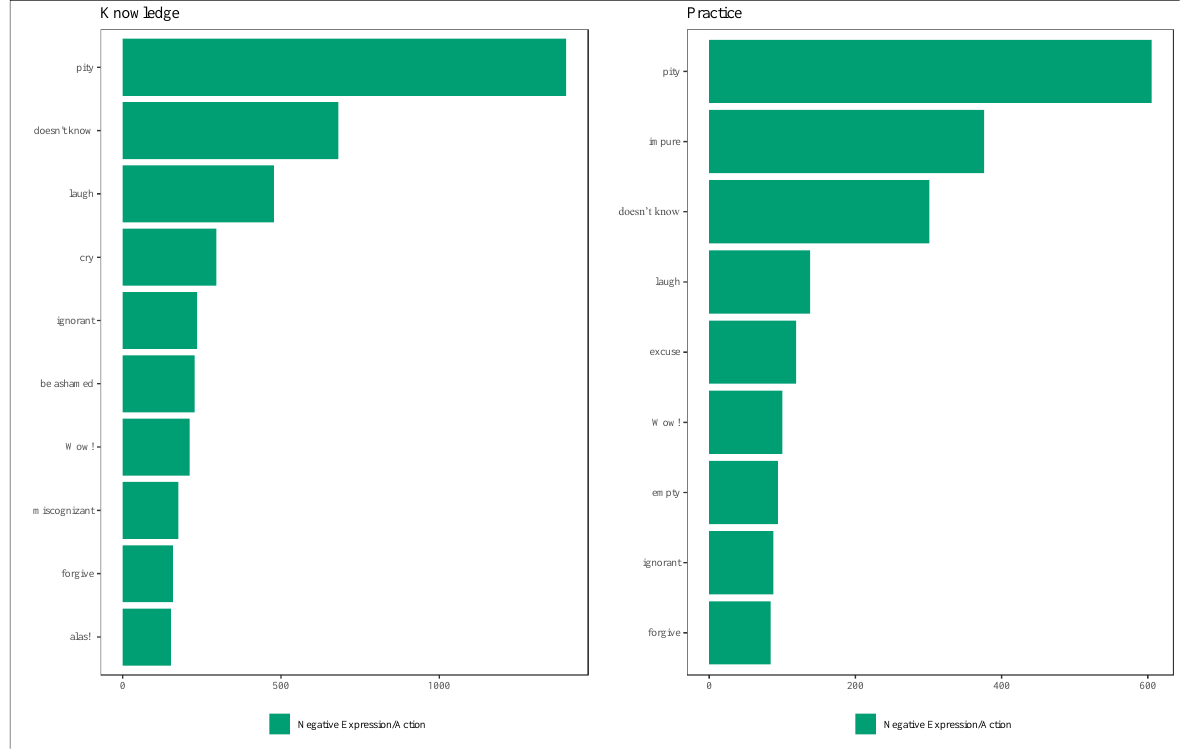
Figure 2. The first ten words with the highest frequency value in the negative expression/action category.